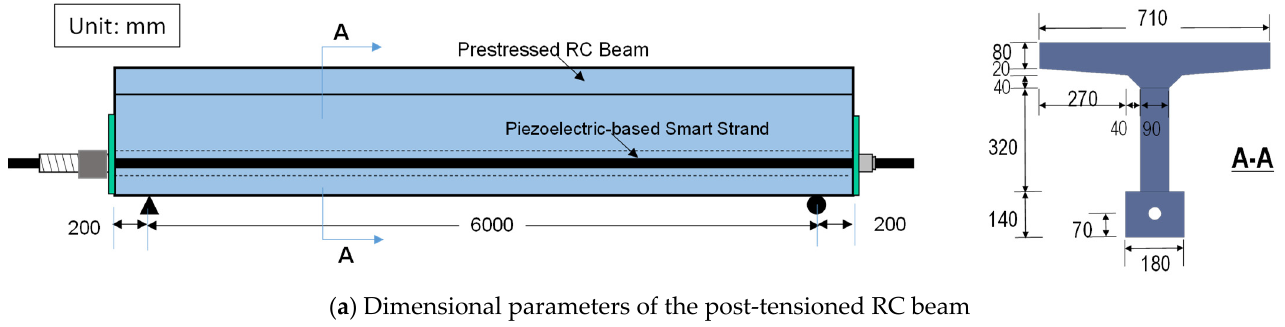
Figure 5. Experimental setup.